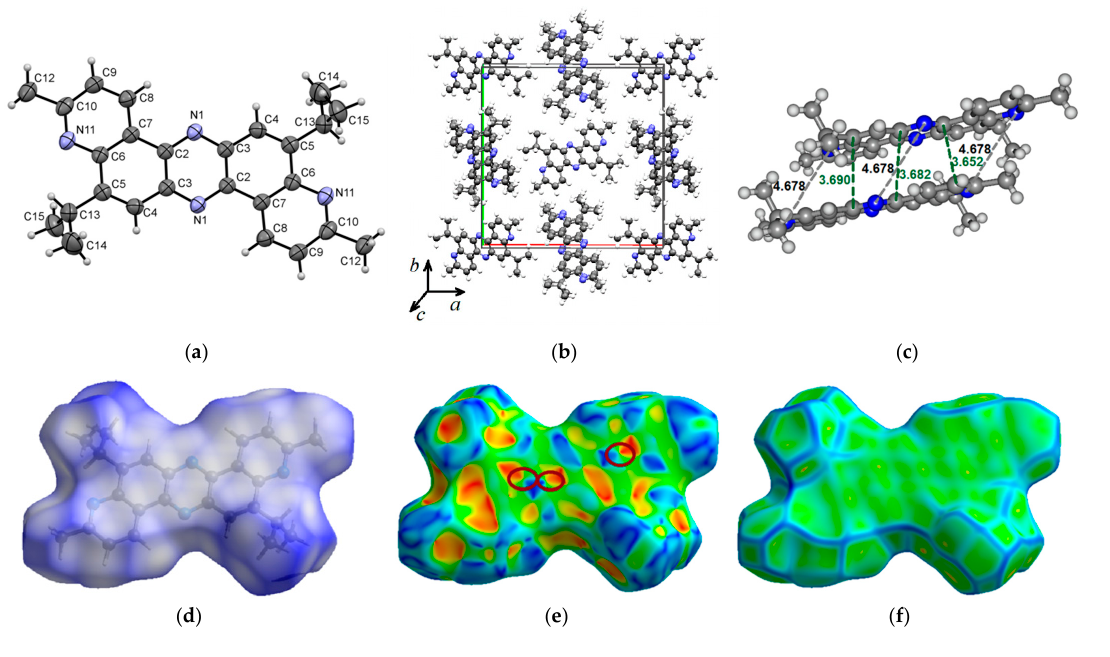
Figure 4. ORTEP diagram of 5,12-diisopropyl-3,10-dimethyldipyrido[3,2- a :3 ′ ,2 ′ - h ]phenazine ( 5 ) with 50% probability. Top view ( a ), packing ( b ) and distances ( c ). Hirshfeld surfaces are mapped with d norm ( d ), shape index ( e ), and curvedness ( f ). Compound 6a crystallizes in the triclinic system ( P- 1 space group) with a = 9.0731(6) Å, b = 9.3169(7) Å, and c = 11.5962(8) Å. Figure 5 presents the molecular (a) and packing (b) structure of phenazine 6a . The distance between the centroids of the azine rings of neighboring molecules is equal to 3.628(1) Å.